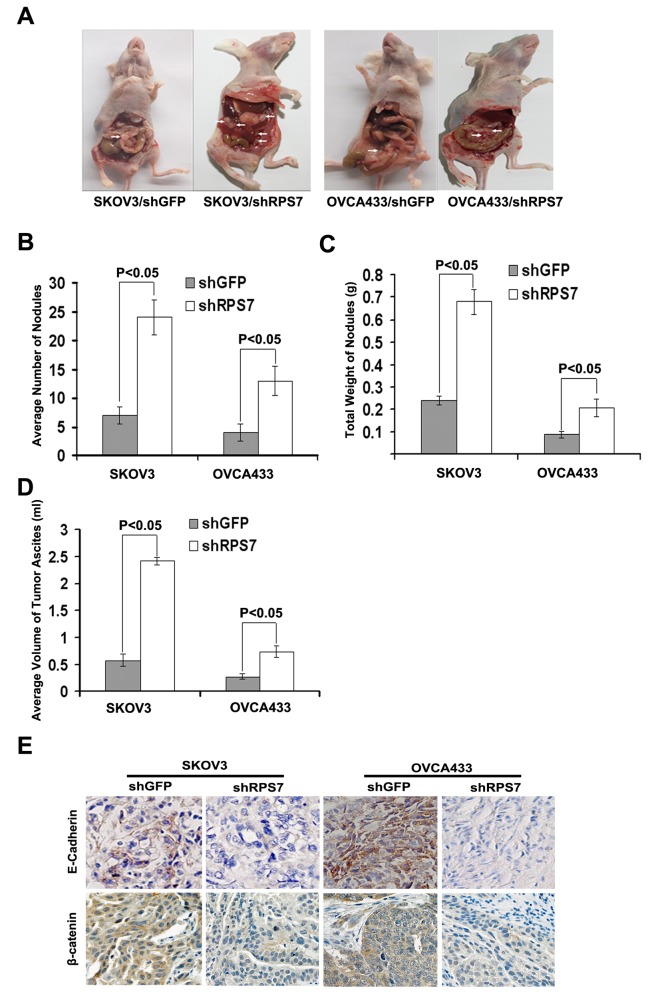
Analysis of intraperitoneally generated xenograft tumors and tissues.
A, Dissection of xenograft tumor. B, Quantitative analysis of the number of nodules in nude mice (P < 0.05). Error bars = 95% CIs. C, Quantitative analysis of the weight of nodules in nude mice (P < 0.05). Error bars = 95% CIs. D, Quantitative analysis of the volume of tumor ascites in nude mice (P < 0.05). Error bars = 95% CIs. E, Immunohistochemical staining of E-cadherin and β-catenin in xenograft tumor tissues. Tissues were stained with mouse anti- E-cadherin andβ-catenin antibodies and visualized with donkey anti-mouse secondary antibody (Magnification×200).